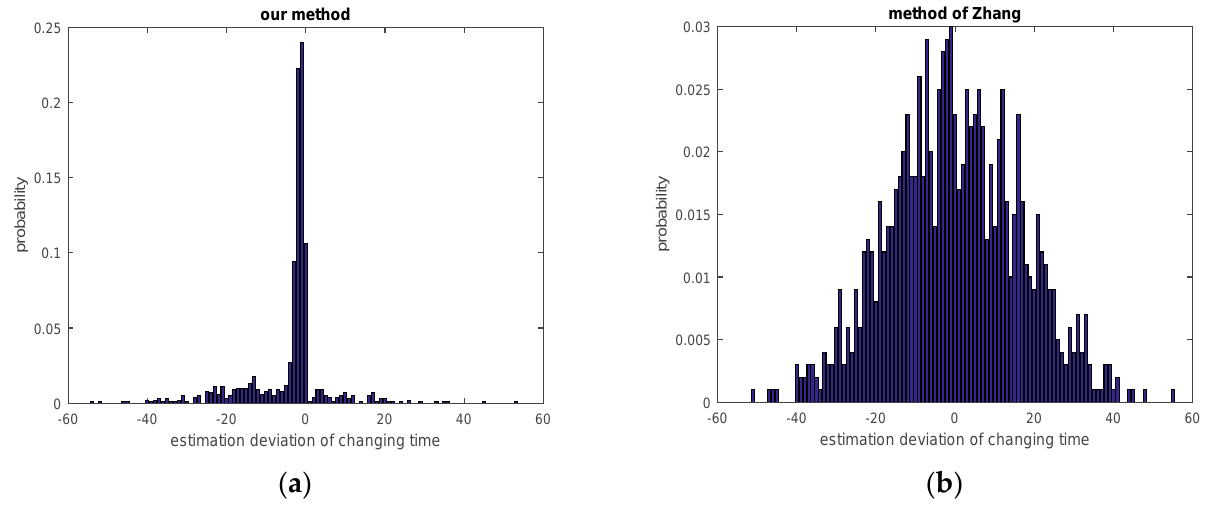
Figure 5. Detection error of ELM. ( a ) The proposed method for detecting the changing point and ( b ) Zhang’s method for detecting the changing point.